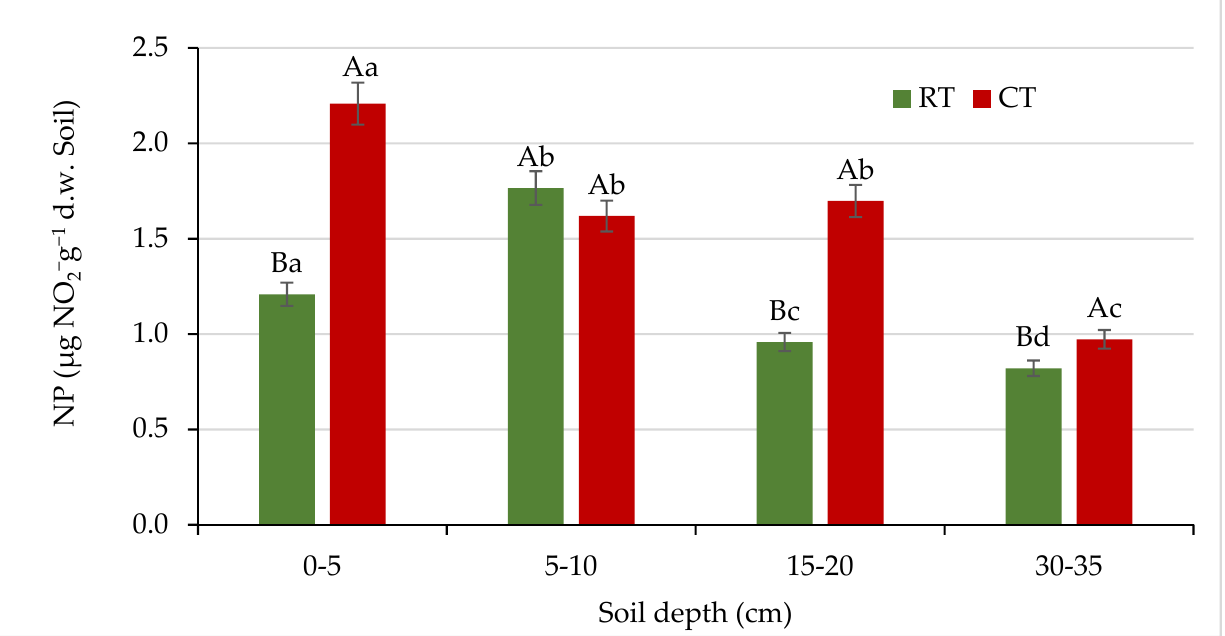
Figure 11. Nitrification potential (NP) in soil under different tillage systems in 2018–2020 (expressed as means for the 3 years, n = 12). Different letters represent significant differences ( p ≤ 0.05) across treatments according to Tukey’s HSD test; lowercase letters within the same tillage system indicate significant differences between soil depths; uppercase letters indicate differences between tillage systems. RT—reduced tillage system; CT—conventional tillage system; d.w.—dry weight of soil; n— number of samples. Vertical bars represent standard errors.